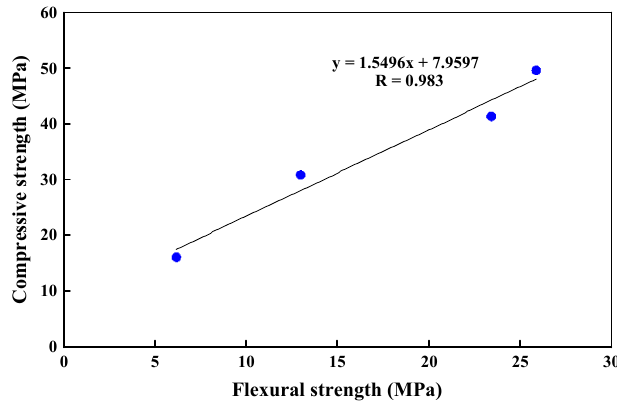
Figure 10. Relationship between compressive and flexural strengths.